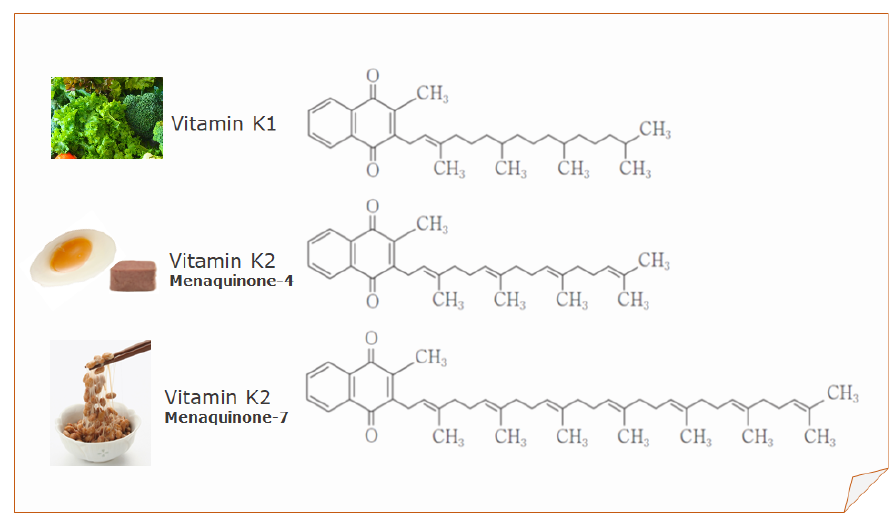
Figure 1. Structure of vitamin K1, menaquinone-4 (MK-4), and menaquinone-7 (MK-7).